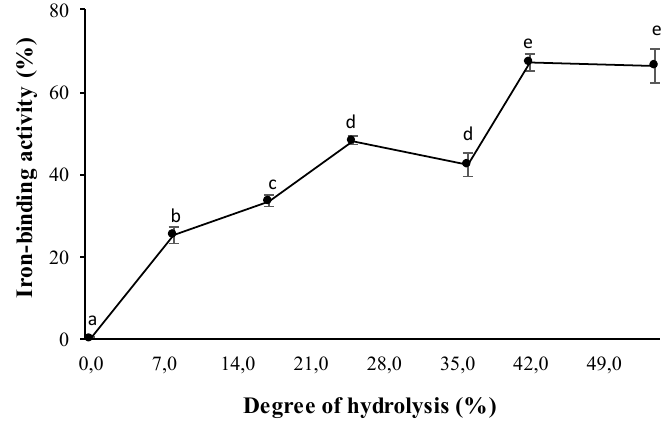
Figure 2. Iron-binding activity of RTVH-B with different DHs. Values are expressed as means ± standard deviation ( n = 4). Different superscript letters (a–e) denote statistically significant differences among treatments ( p < 0.05).